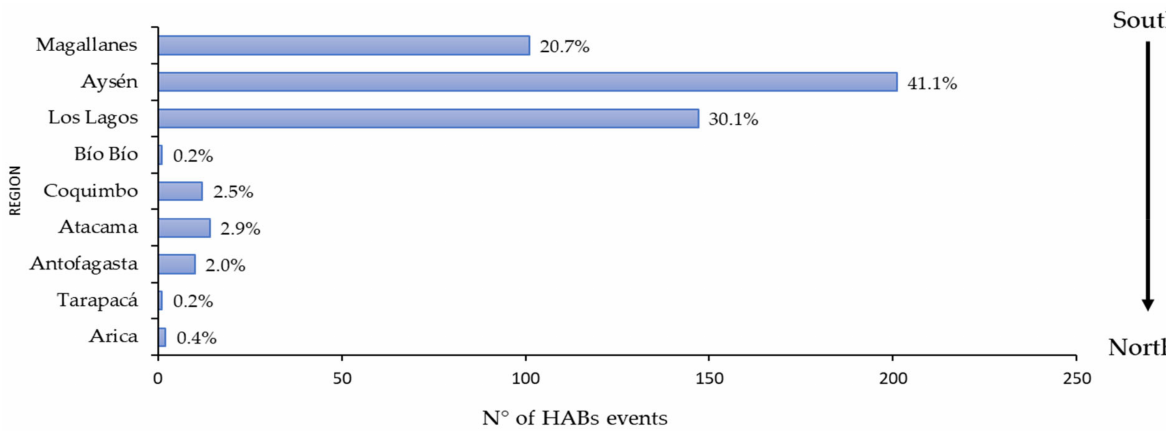
Figure 5. Regional distribution from south to north of HABs events in